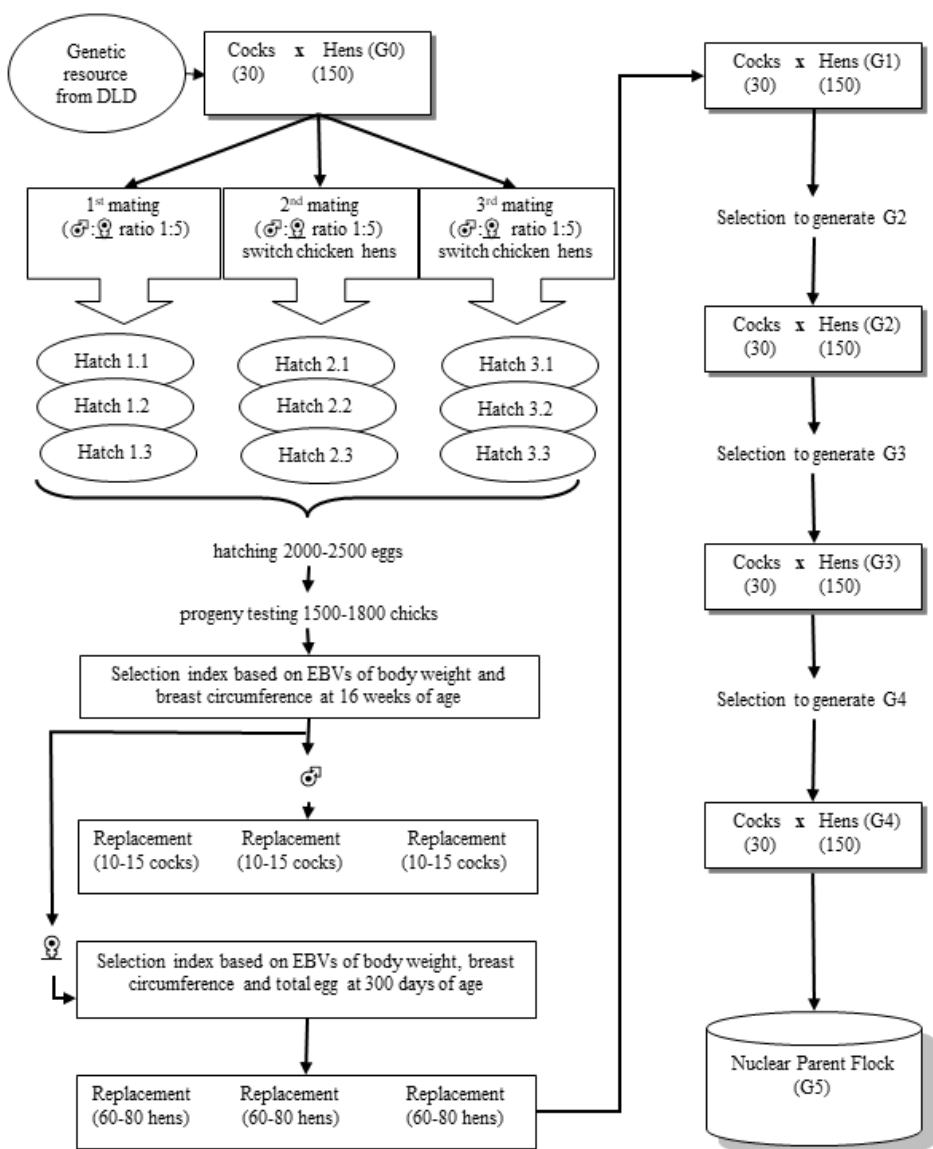
Figure 2. Breeding plan and selection strategy of purebred Thai native and Thai synthetic chickens. Abbreviations: DLD, Thai Department of Livestock Development; EBV, estimated breeding values.